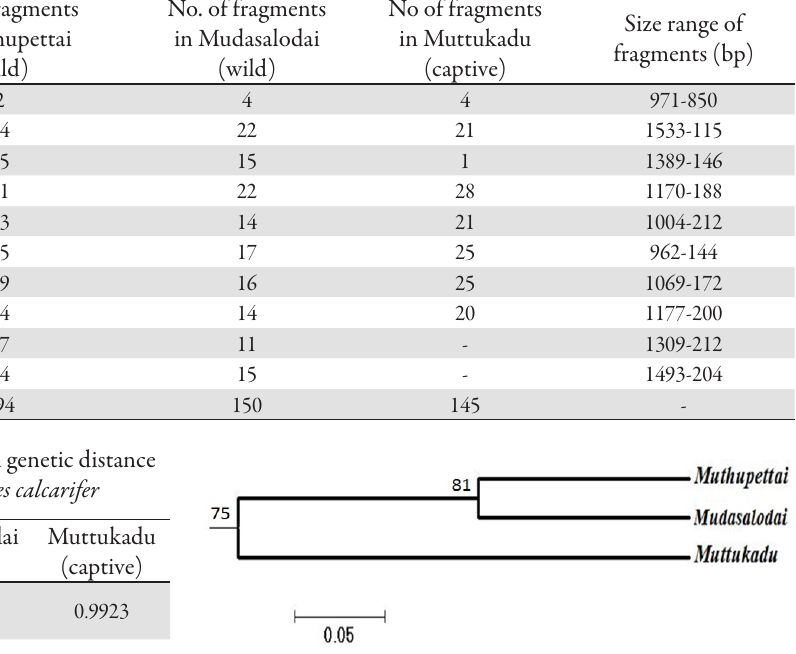
Fig. 2. UPGMA tree (1000 replications) generated from RAPD data of the three populations of Lates calcarifer (scale indicates genetic